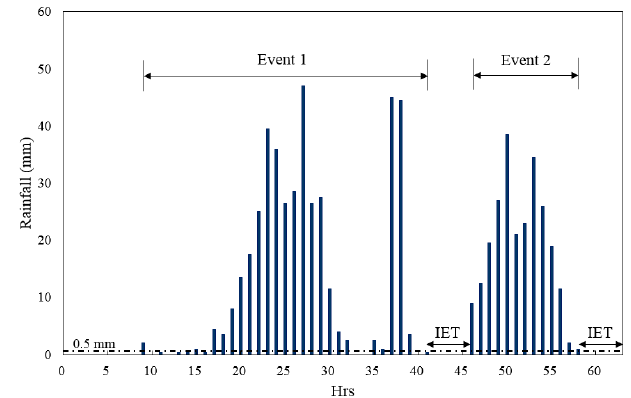
Figure 6. A comparison of simulation results with crowdsourced data for Heavy rain 0908 (2018) along Keelung Road: ( a ) rainfall, water level and social media post volume; and ( b ) crowdsourced data of flooding locations with photos captured in situ.